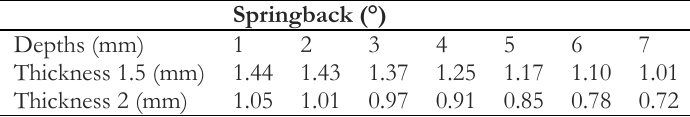
Table 4. Springback of thicknesses 1.5-2 mm.